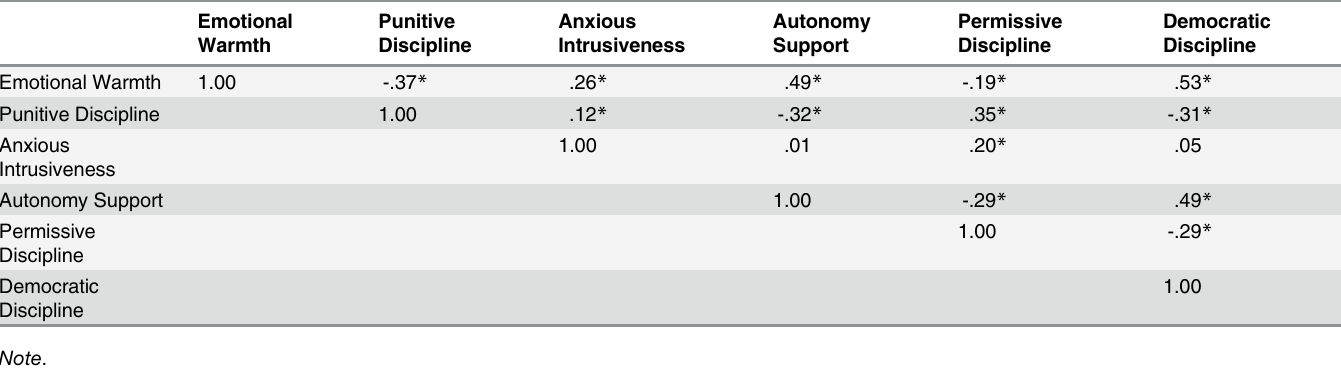
Table 6. Correlation Between Factors in Final Solution (N =